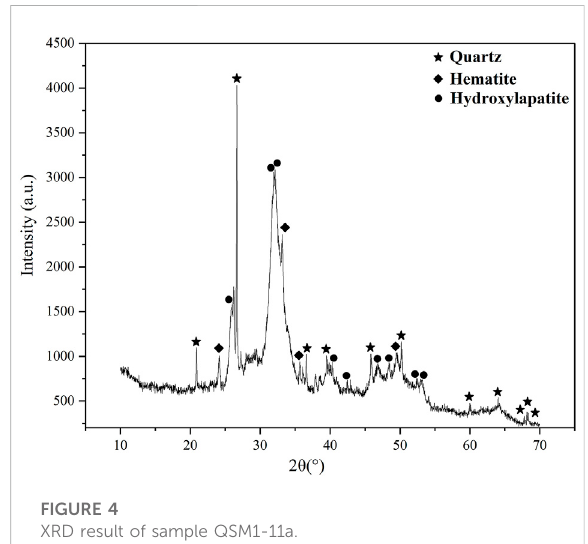
FIGURE 4 XRD result of sample